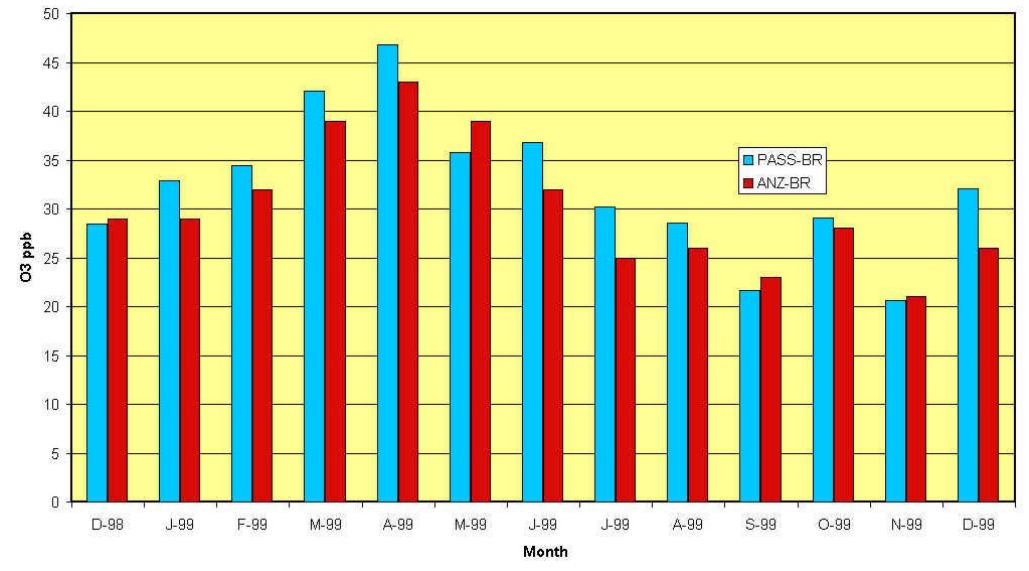
FIGURE 5. Validation results of PASS O 3 by AEP in Beaver Lodge Canada from December 1998 to December 1999 (courtesy from AEP).